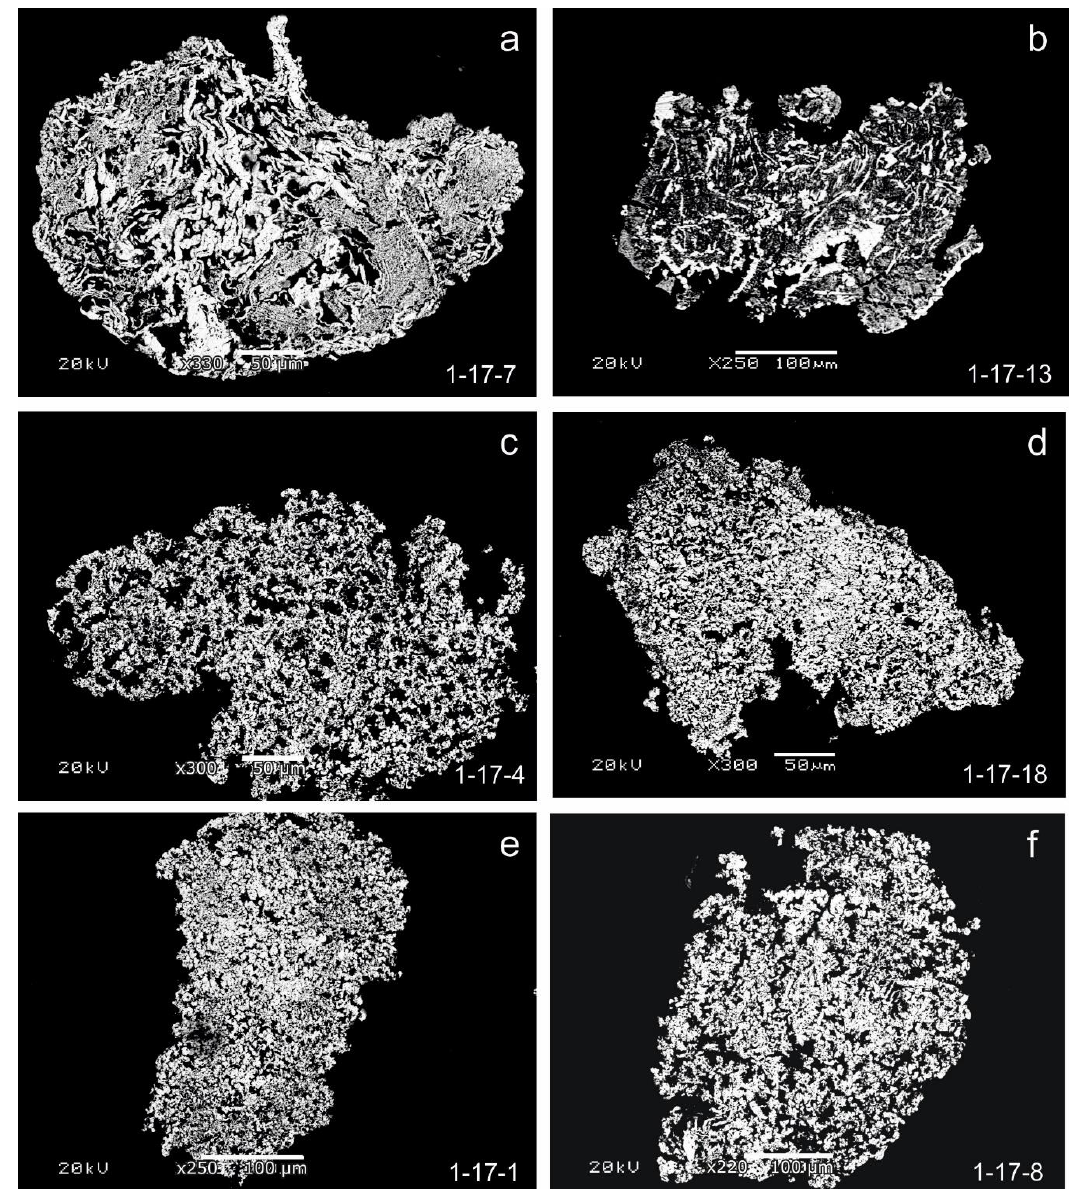
Figure 9. Mustard gold of dendritic structure, ( a , b ) dendritic gold in the center, meandering massive golds, mustard porous gold along the edges in close association with iron hydroxides, ( c – f ) varieties of twiggy gold. Mounted sections, scanning electron microscope, image in the backscattering electron mode.